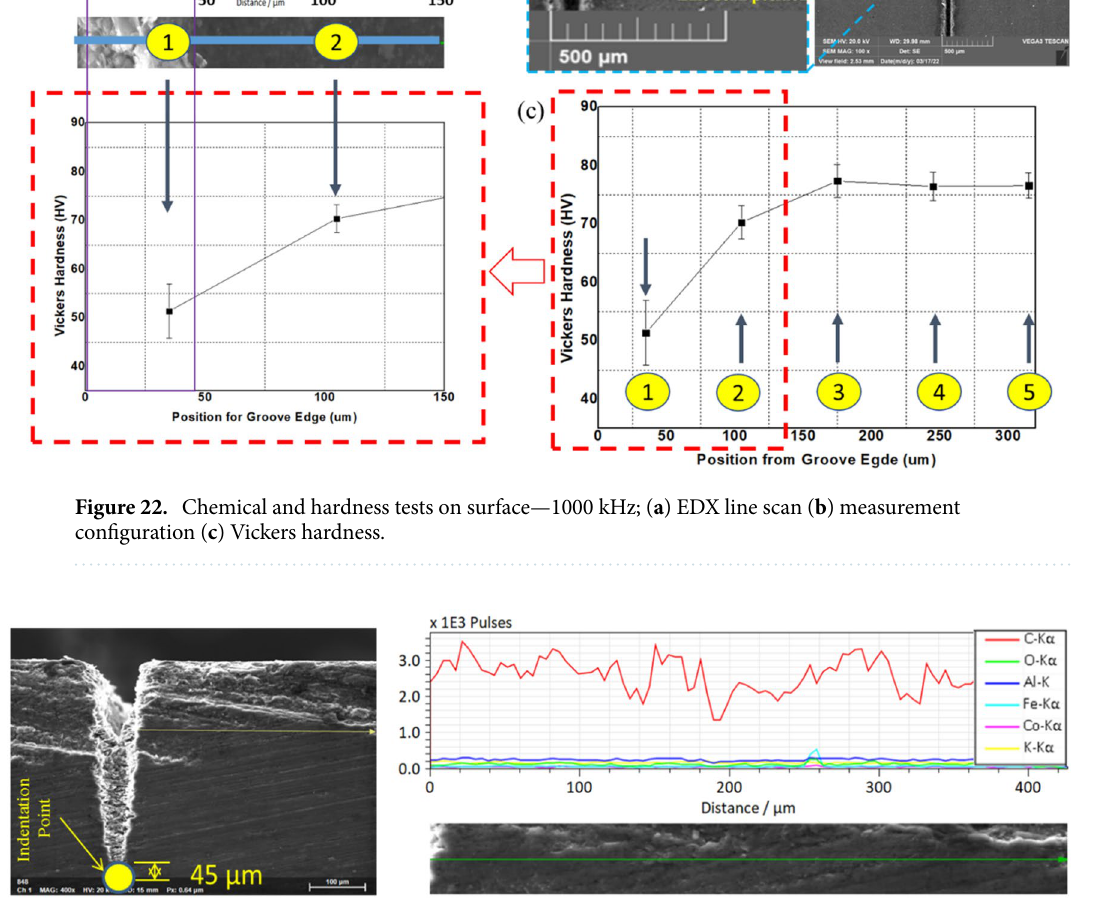
Figure 23. Chemical and hardness tests on cross-section—1000